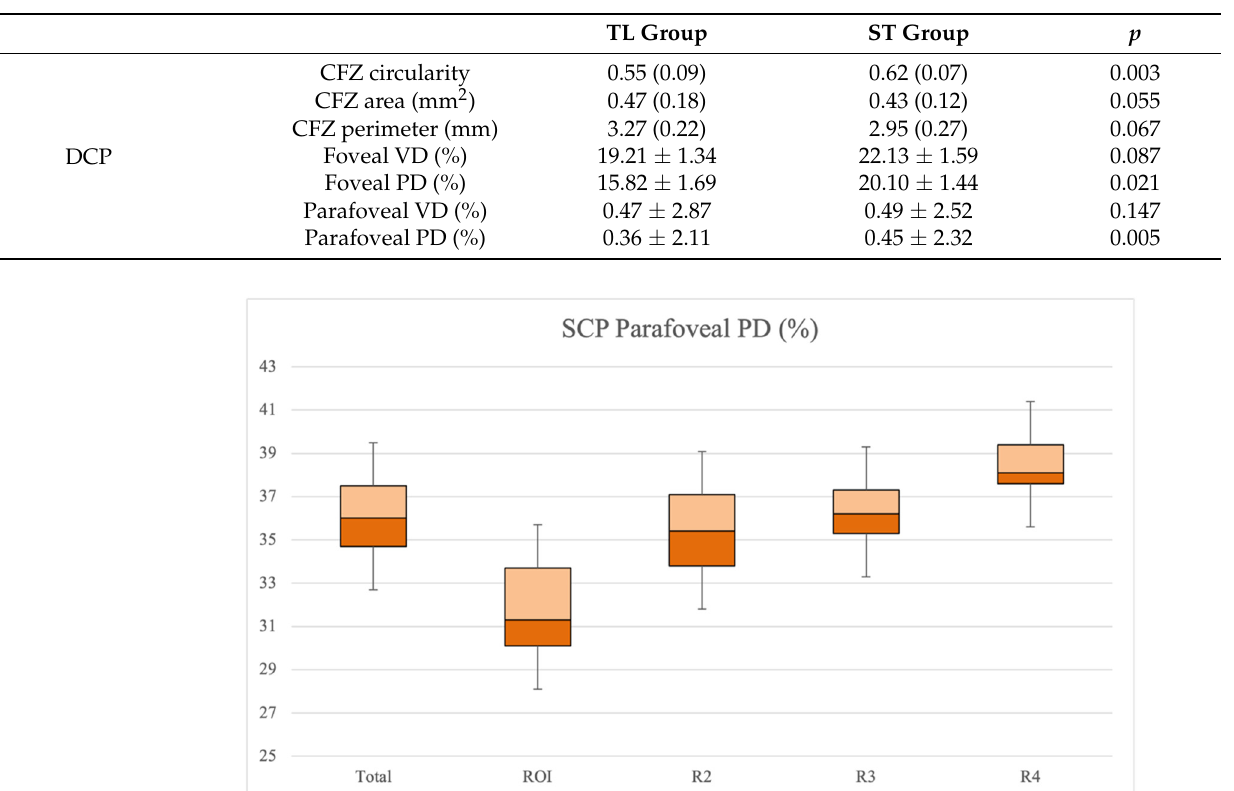
Figure 5. Linear correlation between speed of tissue loss (mm 2 /year) and BCVA variation during follow up period (decimals) in TL group. BCVA = best corrected visual acuity; TL = tissue loss . 4. Discussion Neurovascular coupling, first documented by Roy and Sherrington in 1890 [16], is the ability of the central nervous system to evoke localized changes in blood flow and long-term modifications in vessel density in response to neuronal activity. Glial cells act as intermediaries between neurons and blood vessels in the control of this mechanism, owing to their ability to release vasoactive factors in response to neuronal stimuli [17,18]. The complex functional interactions between glial, neural, and vascular retinal elements can be summed up by the concept of neurovascular retinal unit. Disorders of this interplay have been demonstrated to exert a pivotal role in the pathogenesis and progression of various retinal diseases, such as glaucoma and diabetic retinopathy [11,14,15]. Our paper aimed to investigate the involvement of microvascular blood flow variations in the neu- rodegeneration observed in progressive LMHs. Consistently with our hypothesis, Yeo et